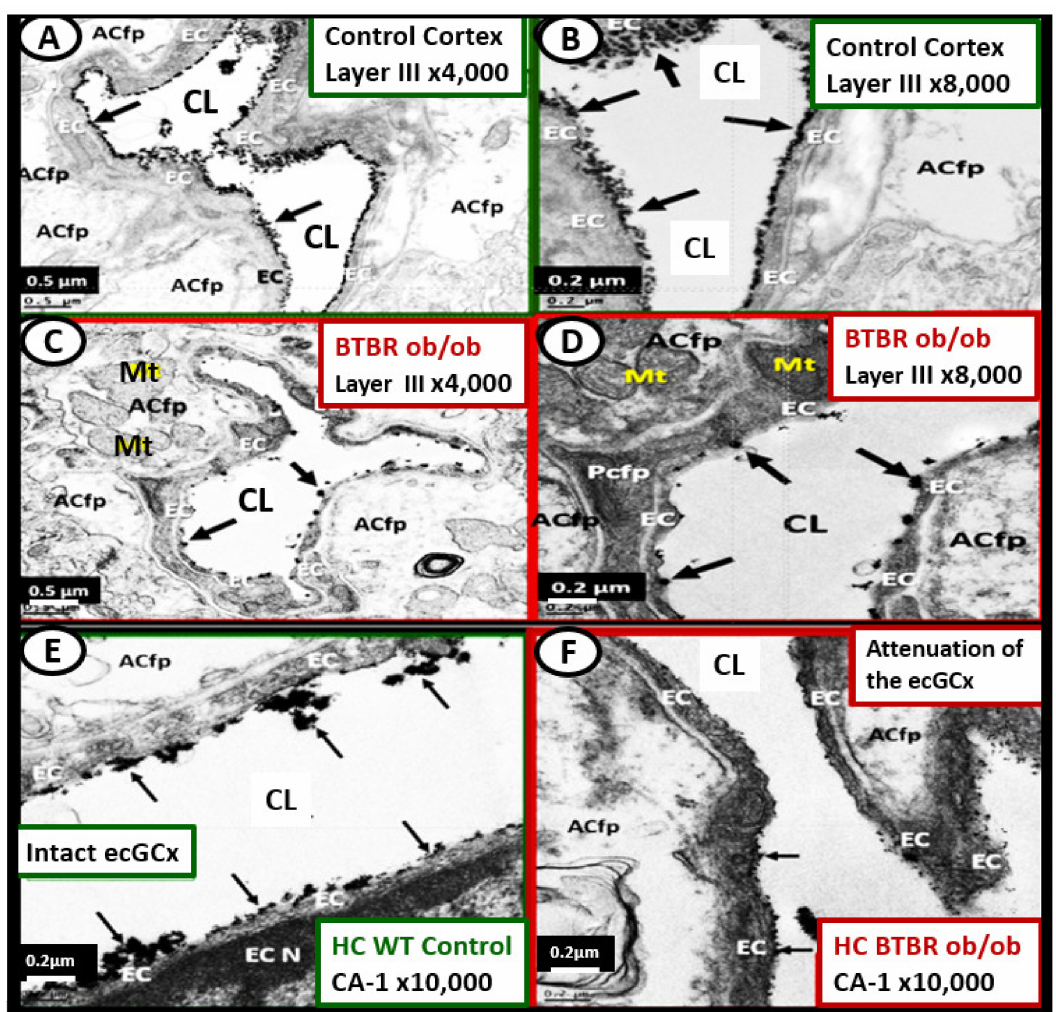
Figure 17. Lanthanum nitrate (LAN) staining of the neurovascular unit (NVU) endothelial glycocalyx (ecGCx) brain endothelial cells (BECs) in the female, obese, insulin resistant, diabetic BTBR ob/ob preclinical mouse models at 20-weeks of age reveal an attenuation and/or loss of the ecGCx as compared to control models. Panels A and B demonstrate the marked electron-dense staining of the ecGCx (arrows) on the luminal surface of BECs with LAN perfusion fixation. Panels C and D depict a marked attenuation of the ecGCx and even in some area it appears to be completely lost. Note that the ecGCx appears to clump and that it is discontinuous as compared to the continuous coverage in control models ( panels A and B ). Panel E demonstrates the decoration of the BECs by the ecGCx in the hippocampal CA-1 regions in control models. Panel F depicts an almost complete loss of the ecGCx on the surface layer of BECs as compared to the control ( panel E ). Here it is important to note that there were no mitochondria abnormalities observed in the BTBR ob/ob models as compared to images that were present in the db/db models previously discussed. Overall, we found the ultrastructural remodeling changes to be less in the BTBR ob/ob models as compared to the db/db in regard to NVU pericytes, ACs, and BBB tight junction abnormalities including less brain atrophy as compared to the db/db models. This may suggest that ecGCx may be an early remodeling change in the diabetic BTBR ob/ob . Images modified and provided by CC 4.0 [52]. Magnification × 4000; scale bar = 0.5 µ m ( panels A and B ); Magnification x8000; scale bar = 0.2 µ m ( panels B and D ); Magnification × 10,000; scale bar = 0.2 µ m ( panels E and F ). ACfp = astrocyte foot processes; CA-1 = Cornu Ammonis-1; CL = capillary lumen; HC = hippocampus; Mt = mitochondria; Pcfp = pericyte foot